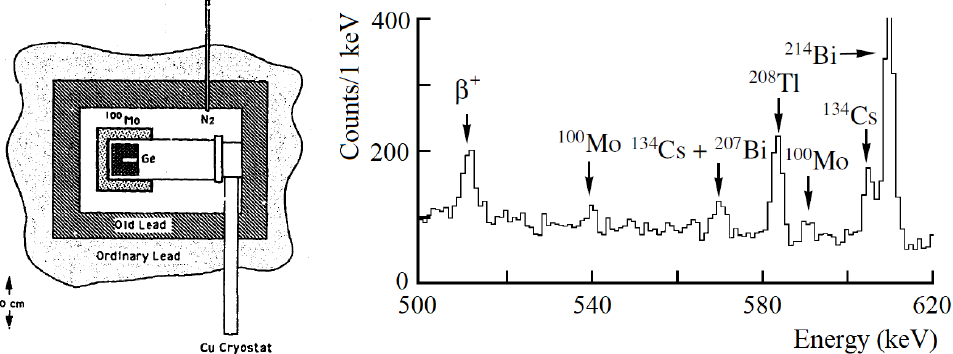
Figure 2. ( left ) Scheme of the setup used in the Soudan experiment. ( right ) Energy spectrum obtained by the Soudan experiment over 415.43 days in the energy range corresponding to the 2 β − decay of 100 Mo to the 0 + state of 100 Ru at 1130.3 keV, which is accompanied by two γ quanta (539.5 keV and 1 590.8 keV). Reprinted from Reference [16] with permission from